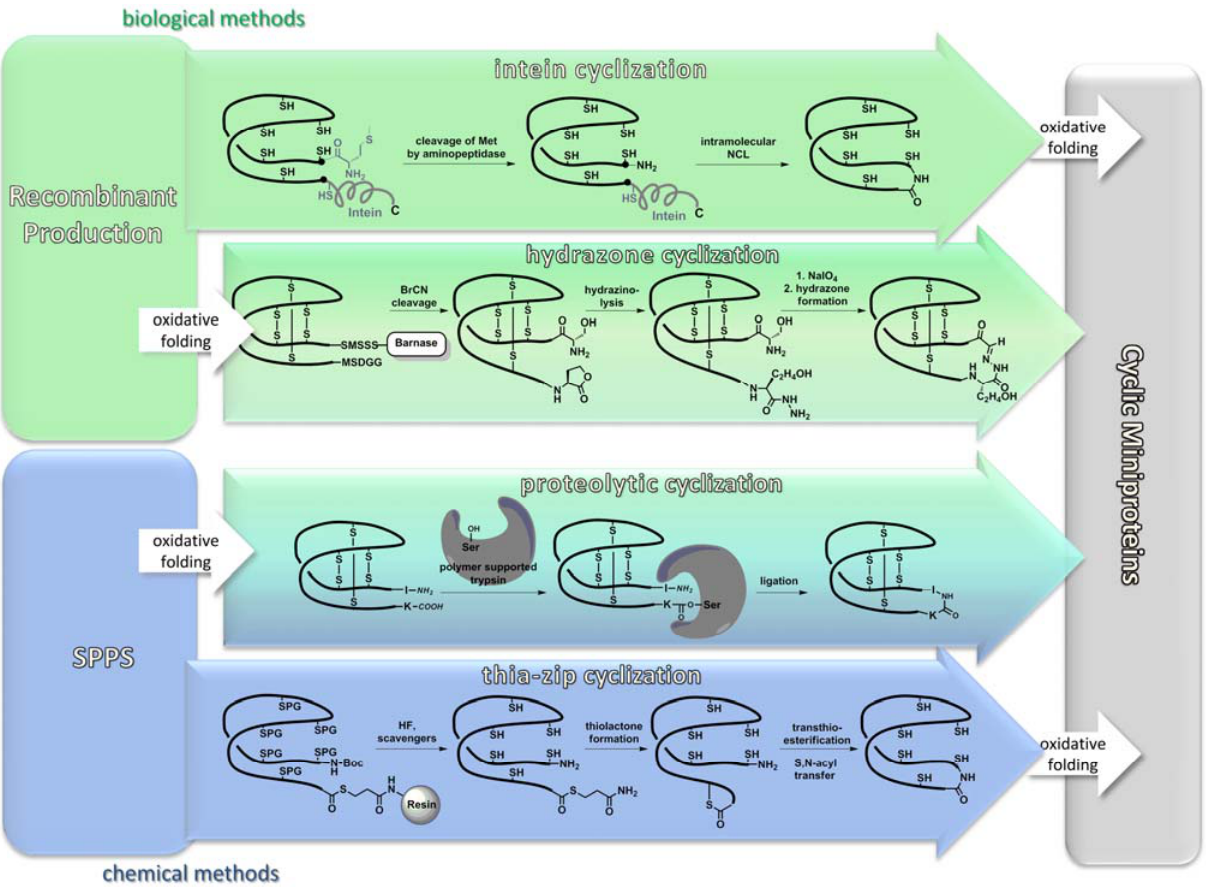
Figure 3. Common strategies for backbone cyclization. Biosynthetic methods are depicted in green, chemical methods in blue, hybrid strategies are shown in turquoise. References: Intein cyclization: [39–41]; hydrazone cyclization: [43]; proteolytic cyclization: [44,45]; thia-zip cyclization: [46,47].